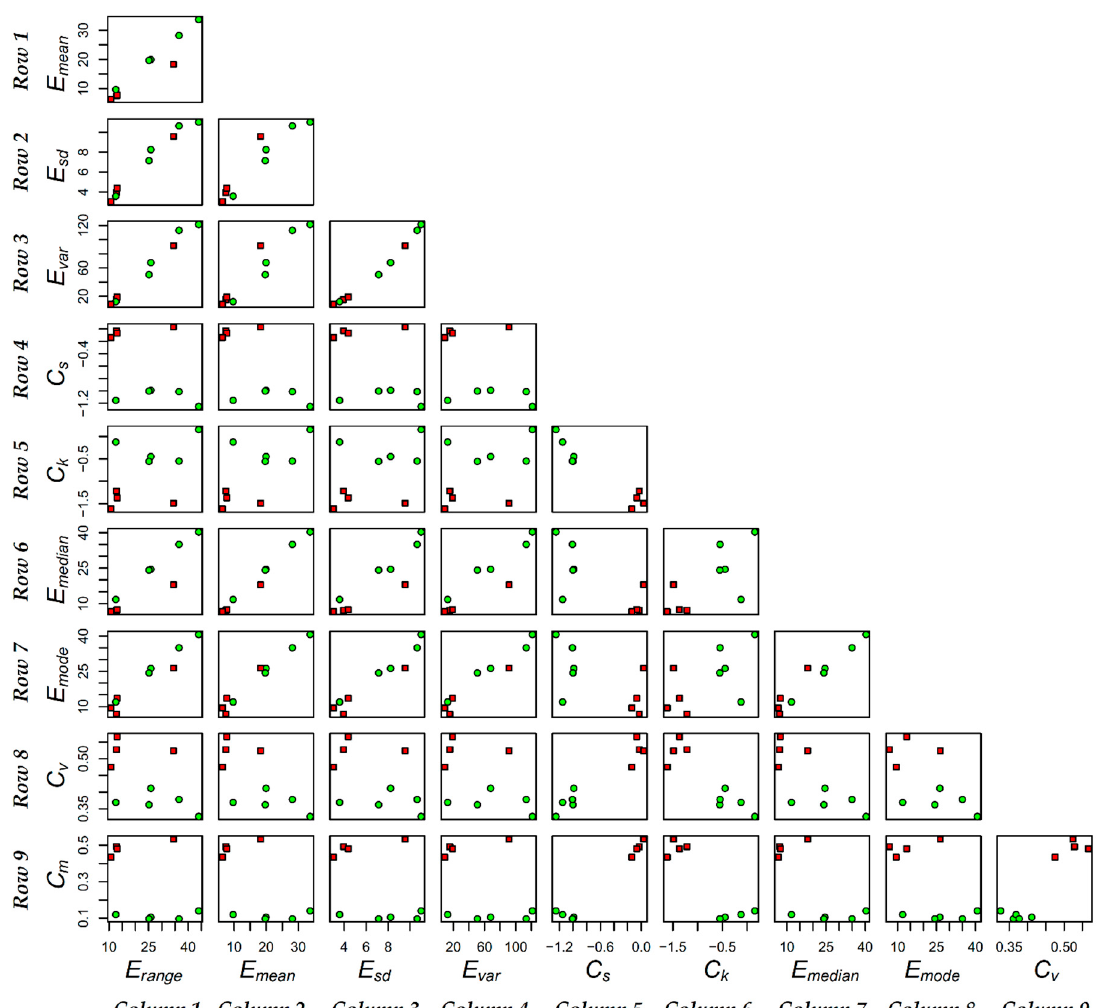
Figure 3. Scatter matrix based on numerical parameters of energy consumption data of nine pumps. Four red points in each scatter were recognized as variable-speed pumps, while five green points were recognized as constant-speed pumps.